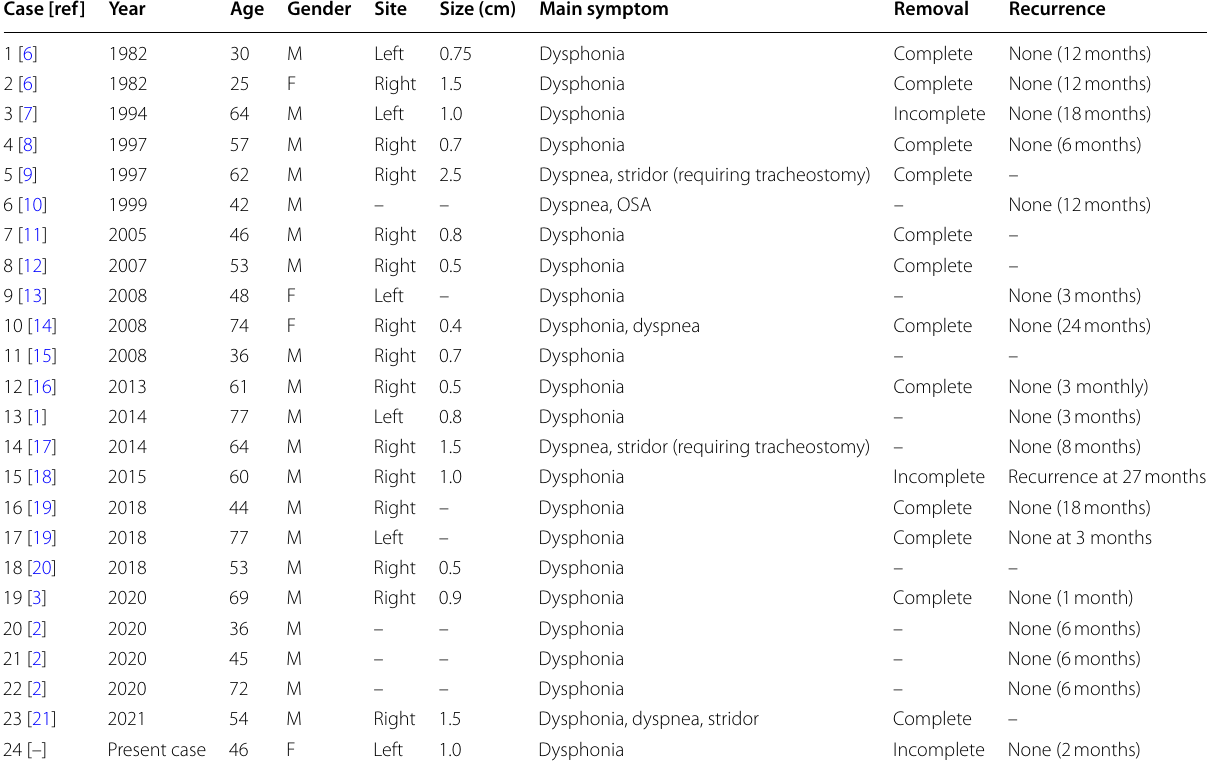
[Ref] Reference; M Male; F Female,